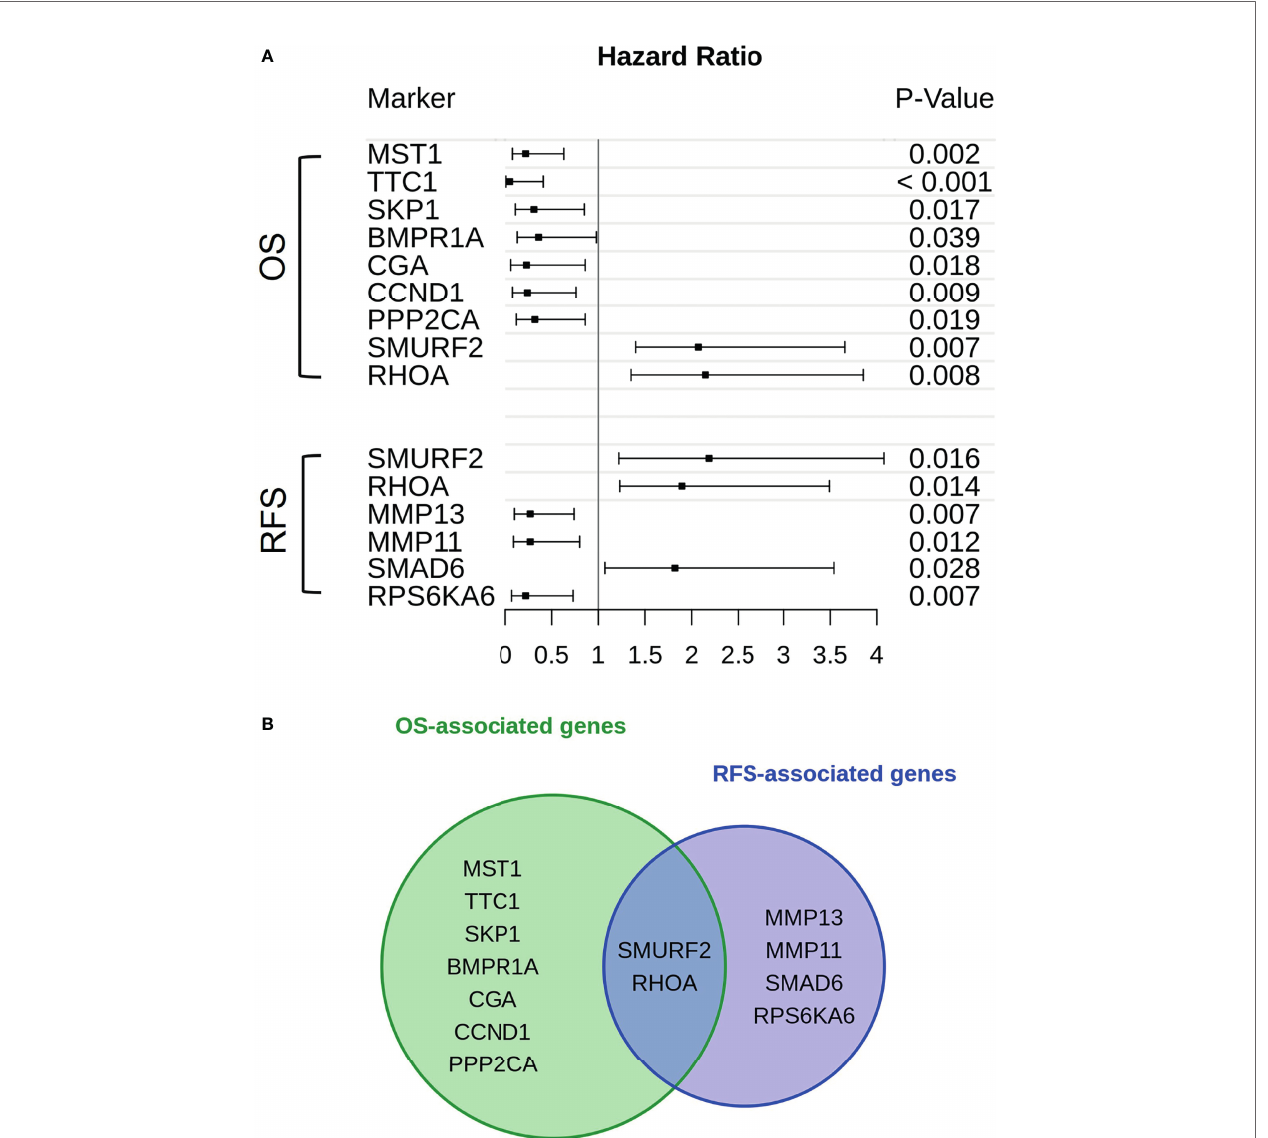
FIGURE 2 | Genes in association with CAF-signaling impact patients ’ survival. (A) For every gene that is hinted to impact patients ’ overall survival (upper group) or recurrence-free survival (lower group) hazard ratios were calculated. The span of these values, including a risk estimate was visualized via forest plot. Of the original 24 patients available, only 19 were used in the calculations. Five patients were excluded due to missing survival data. The p-value was calculated by Score-logrank test. (B) Both groups of genes, either in association with overall survival (green) or recurrence-free survival (blue), were compared and overlaps between them were also